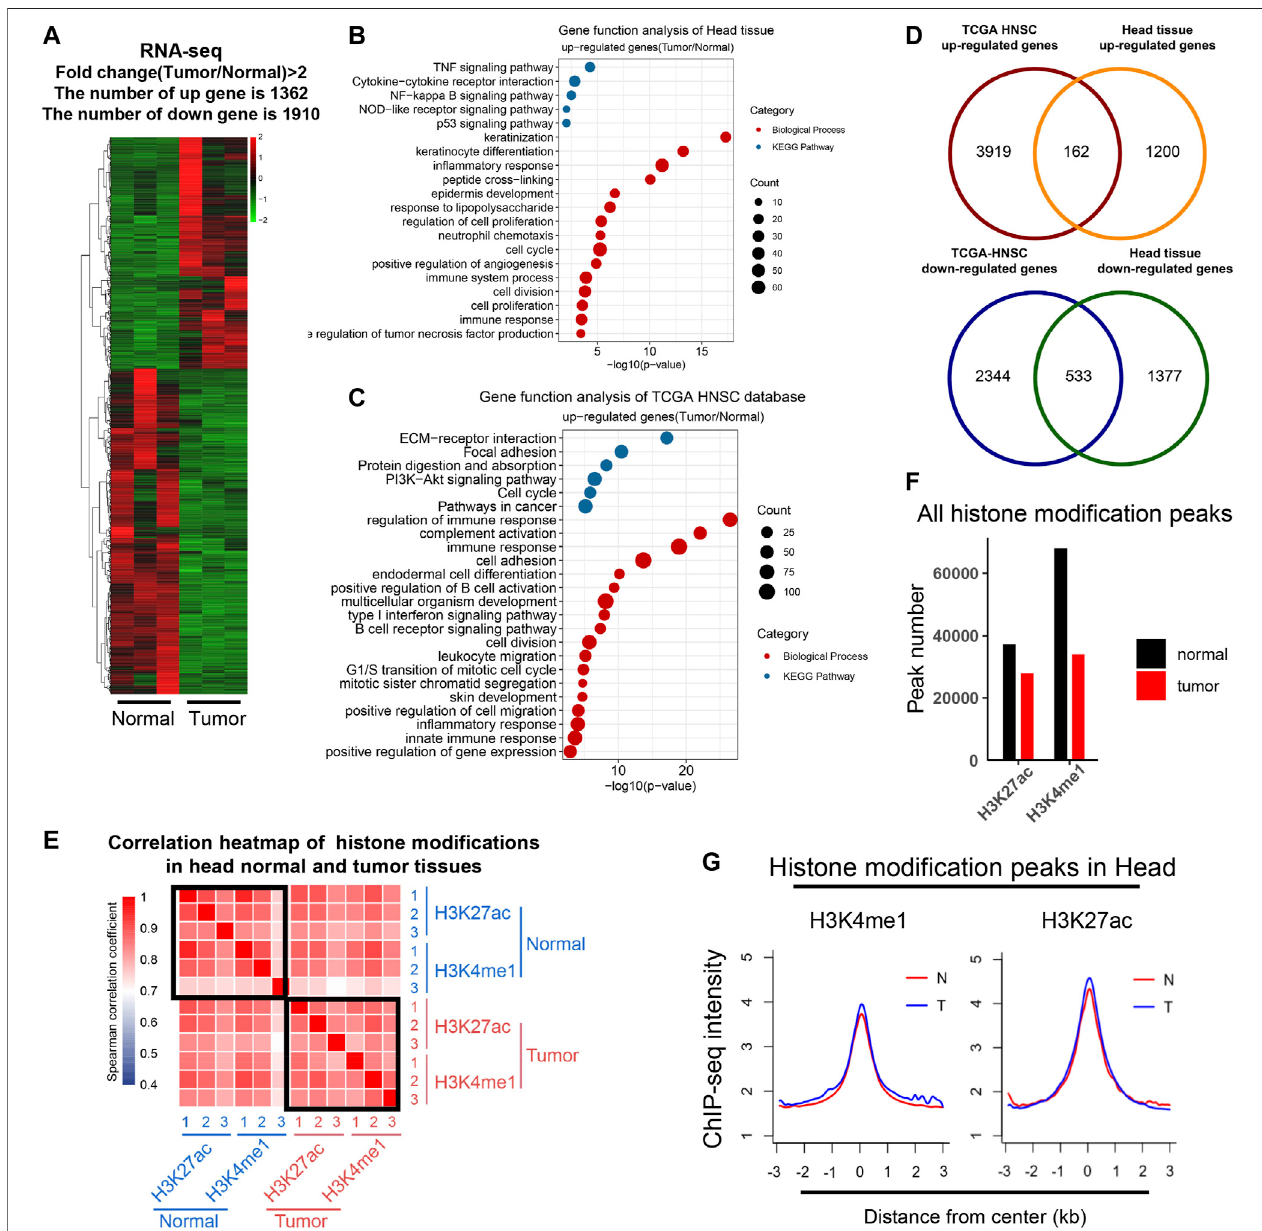
FIGURE 1 | Transcriptomic and epigenomic pro fi ling in an HNSCC model. (A) Heat map showed the differential gene expression (FPKM) between normal and tumor tissues; upregulated (red) and downregulated (green) genes ( n (cid:1) 3, Fold change ≥ 2). (B and C) Bubble plots showed biological process (red) and the KEGG pathway (blue)enrichmentanalysisofupregulatedgenesinmouseheadtissues (B) andtheTCGA HNSCdatabase (C) ,respectively.Itemswereorderedbythe p value; the size of the dot represented the enriched gene count. (D) Venn diagrams showed the number of overlapped upregulated (up) and downregulated DEGs (bottom) between the head tissue and the TCGA HNSC database. (E) Heat map representing correlations based on H3K4me1 and H3K27ac occupancy on mouse genome.CorrelationswerecalculatedbytheSpearmancorrelationcoef fi cient. (F) Barplotshowedthenumberofsigni fi cantpeaksofH3K4me1andH3K27acinnormal andtumortissues. (G) MetageneplotofmeanChIP-seqsignalofH3K4me1andH3K27acacrosstheindividualpeaksofeachmark.Metageneanalysiswascenteredon the middle of peaks and 6 kb around peak centers are displayed (3 kb upstream and 3 kb downstream). The ChIP-seq data of each histone marks were merged from three individual